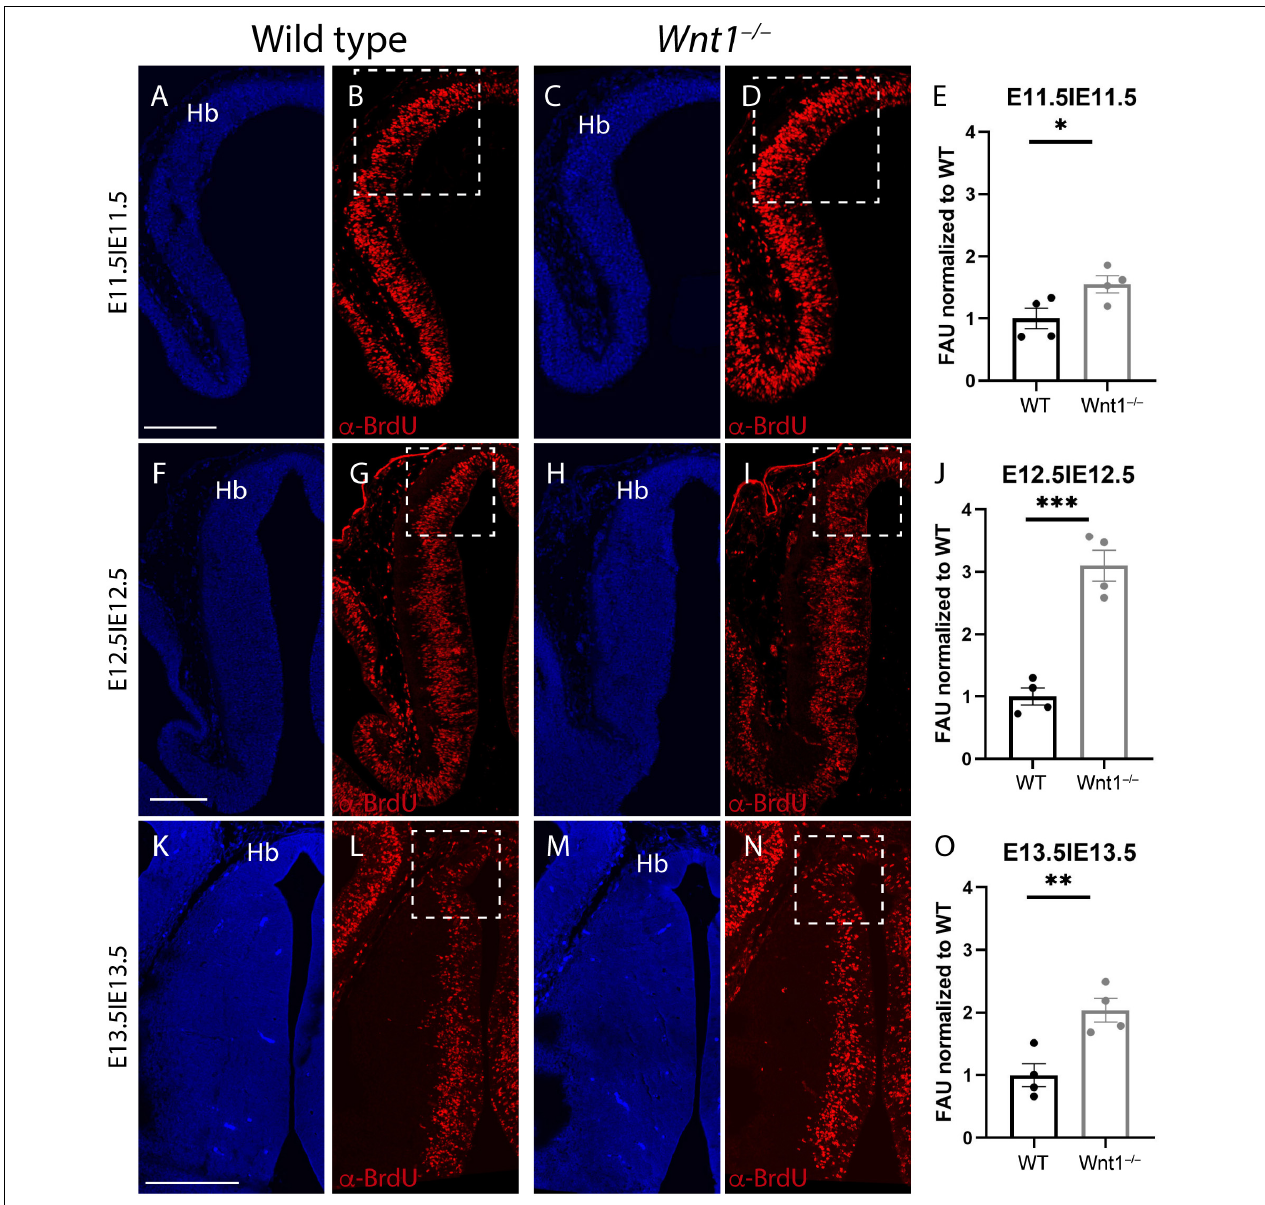
FIGURE 4 | Proliferation analysis. Brain coronal sections at embryonic stages E11.5 (A–D) , E12.5 (F–I), and E13.5 (K–N) . Pregnant mice were injected with BrdU on the designated day. The embryos were collected 2 h later. Immunofluorescence against BrdU (B,D,G,I,L,N) showed more proliferation in the Wnt1 − / − brains than in the wt brains (E,J,O) . Significance among wt and Wnt1 − / − proliferation was analyzed by an unpaired t -test. Significant differences were found ( E ∗ < 0.05; J ∗∗∗ < 0.001; O ∗∗ < 0.01), being proliferation in the mutant higher than in the wt. Four samples of each genotype have been analyzed. Hb, habenula. Scale bar: 200 µ